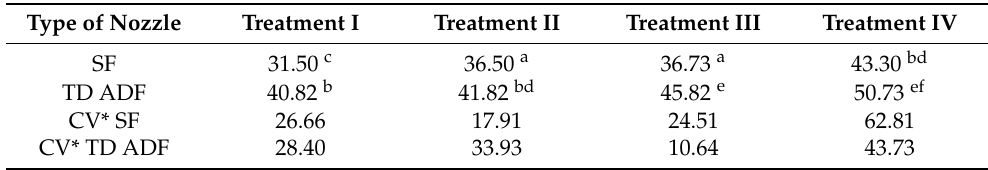
Table 2. Tracer recovery rate solutions on sugar beet leaves using SF and TD ADF nozzles in tests under field